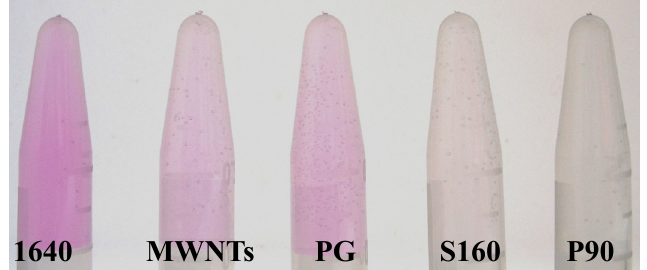
Figure 2. The color change of phenol red in supernatants of carbon nanoparticles ( CNPs) after 2 h incubation in serum-free